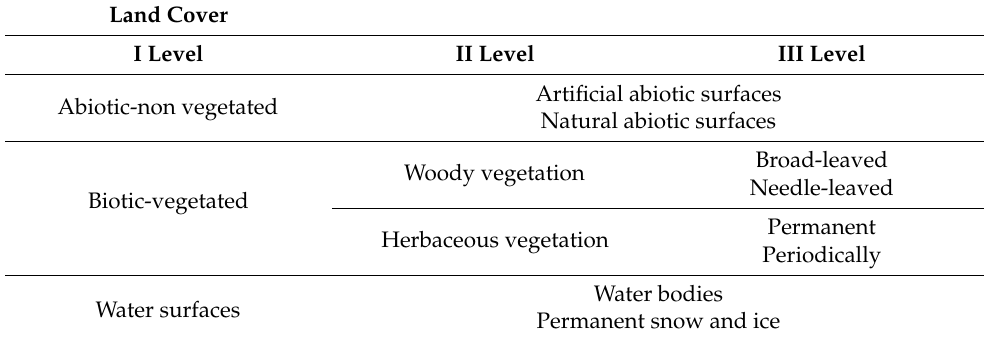
Table 1. Land cover classification